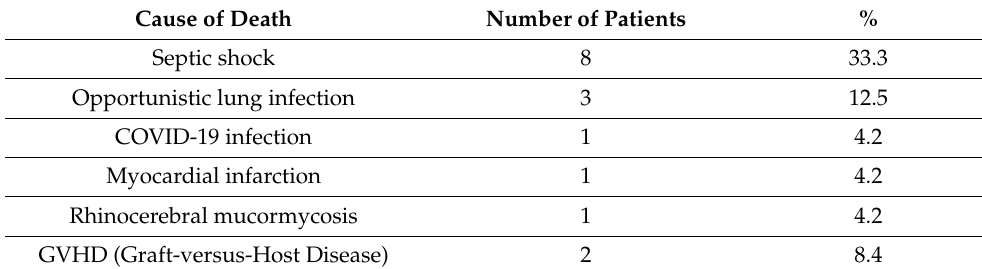
Table 4. Causes of mortality.